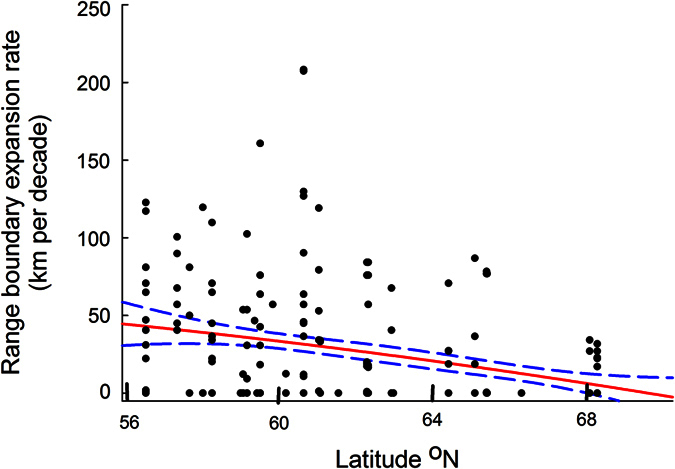
Rates of northward range boundary shifts of moths in Sweden decrease with increasing latitude.Figure show rates of northern range boundary expansion rate (in km per decade) during the period 1973 to 2014 in relation to the northern boundary limit in 1973. Red line represents least squares linear regression (F1,334 = 47.18, R2 = 0.12, P < 0.0001, rs = −0.43, n = 336, P < 0.0001). Dashed blue lines indicate 95%CI.